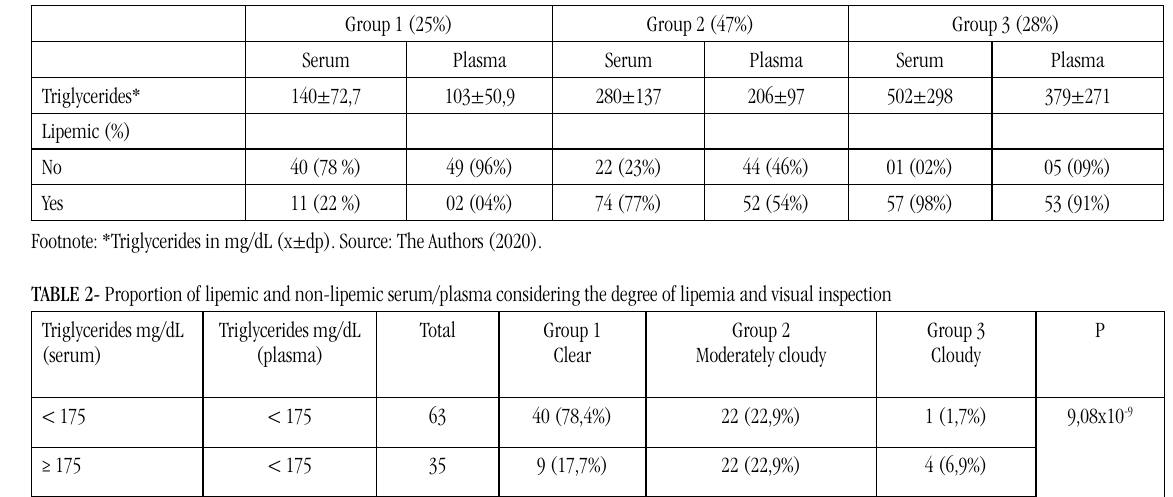
TABLE 1- Categories of visual inspection taking into account the concentrations of triglycerides obtained in serum and plasma